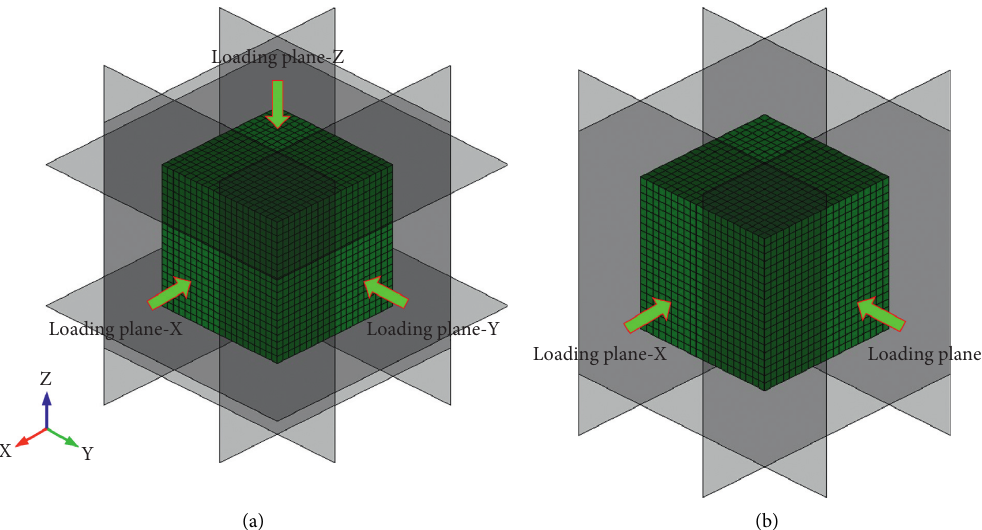
Figure 14: Schematic diagram of the multiaxial loading of the D-F model and the modified D-F model: (a) the triaxial compression and (b) the biaxial compression.